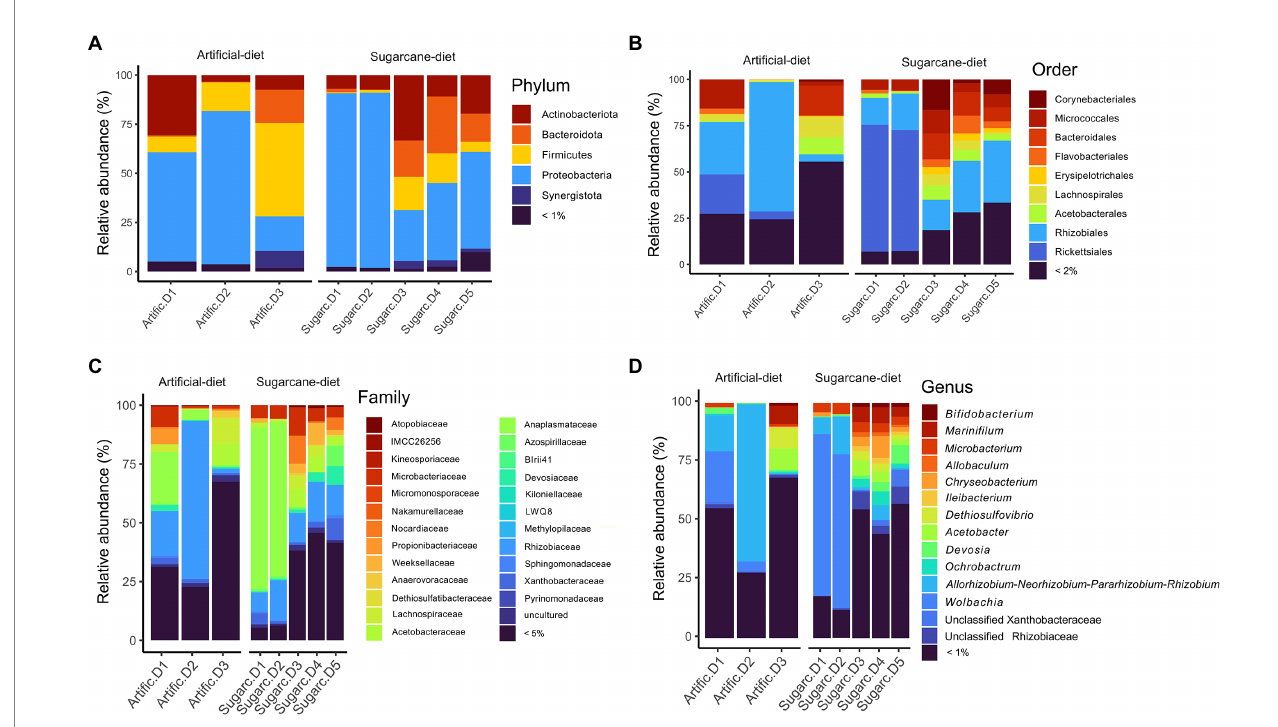
FIGURE 1 Relative abundances of bacterial taxa at (A) phylum, (B) order, (C) family and (D) genus level found in digestive tracts of Diatraea saccharalis